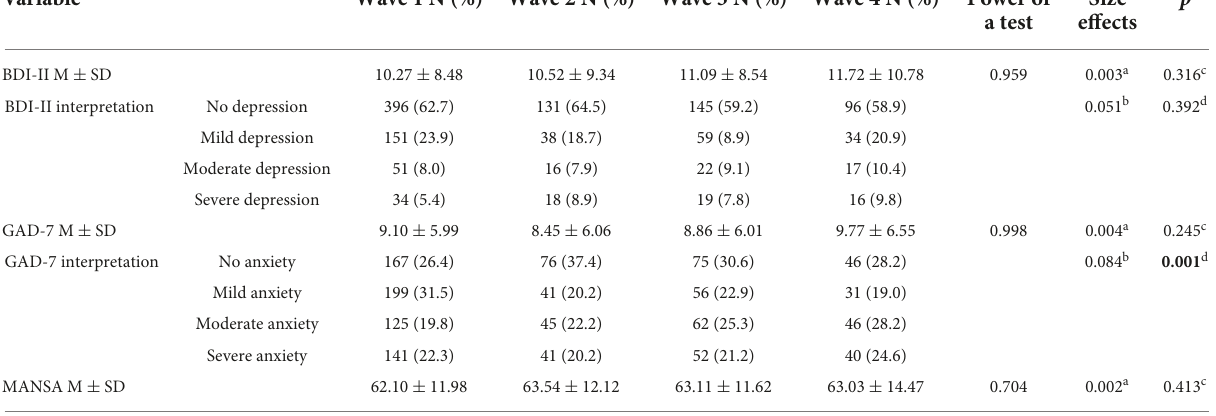
TABLE 2 Comparison of the BDI-II, GAD-7, and MANSA scales in relation to the different stages of the study. Variable